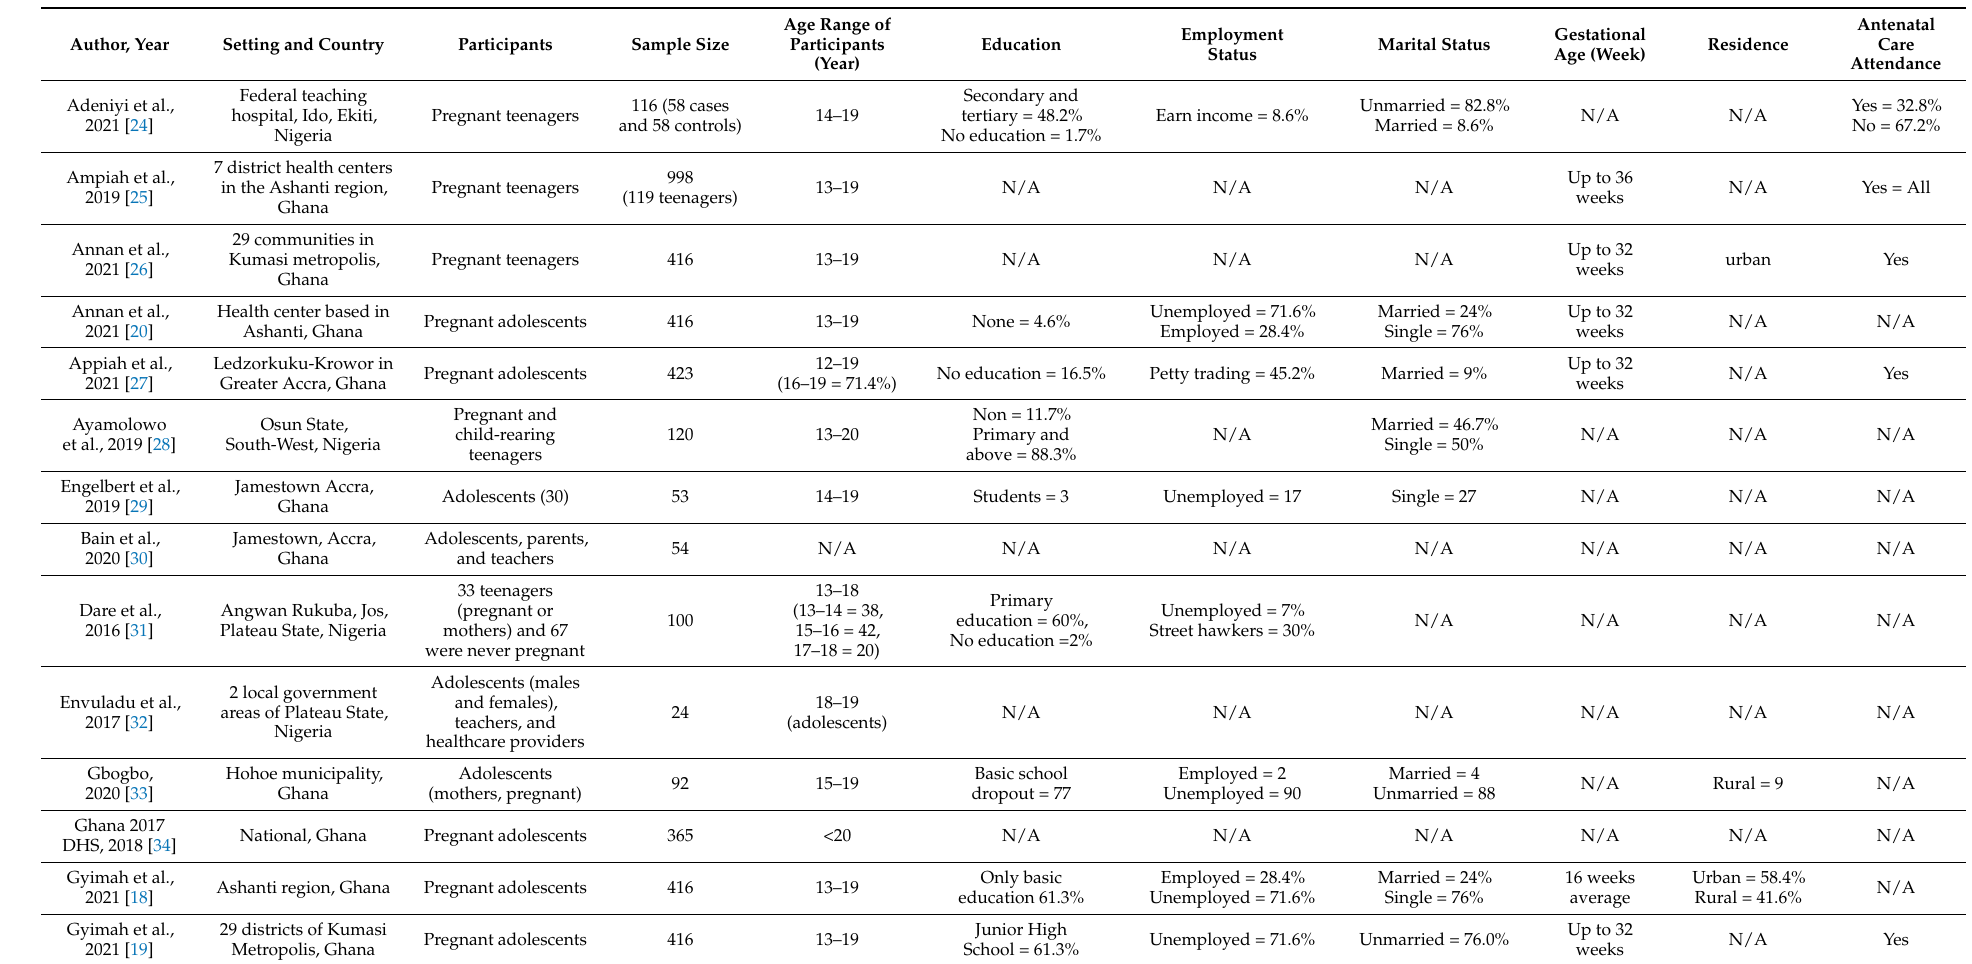
Table 1. Characteristics of included